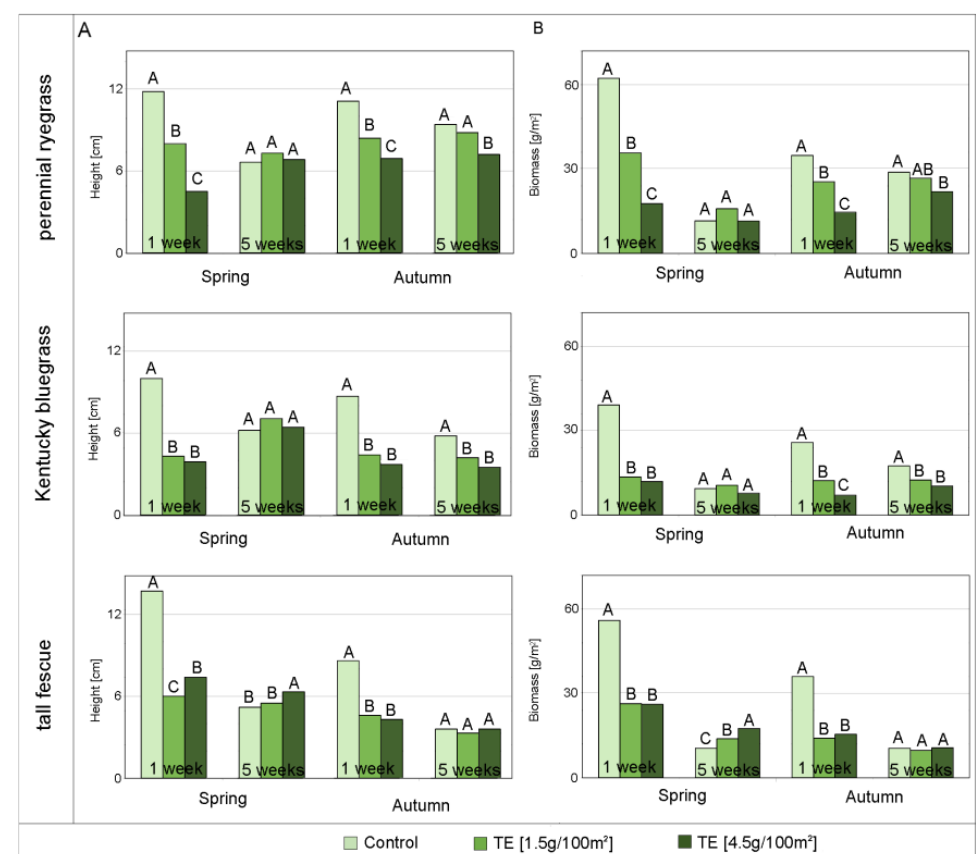
Figure 3. The effect of TE doses on grass regrowth in spring and autumn, after 1 and 5 weeks post-TE-application: ( A ) height [cm]; ( B ) Dried clippings biomass [g/100 m 2 ]. Letters designate homogeneous groups within the term, based on the post-hoc Duncan test, with probability ≥ 95%. ANOVA analysis is presented in Supplementary Materials Table S2.